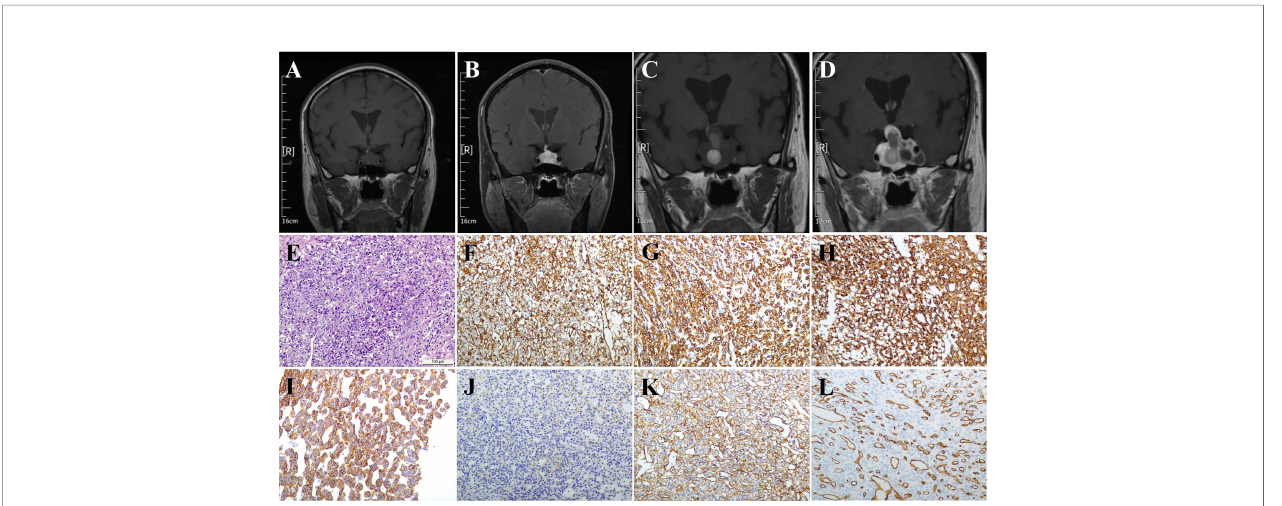
FIGURE 1 | MRI and pathological images. (A, B) Five years before the operation: Coronal MRI and enhanced MRI images indicated the sellar lesions with a size of approximately 21.0 × 14.5 × 12 mm had cystic structures and was inhomogenously enhanced. (C, D) Three months before the operation: Coronal MRI and enhanced MRI images indicated the sellar lesions with a size of about 37 × 35 × 24 mm had variable signal intensity and multiple apoplectic events. (E) Hematoxylin- eosin (H&E) staining indicated the mild cell morphology with rare nuclear division; immunohistochemical staining indicated that the tumor cells were positive for (F) Vimentin, (G) SMA, (H) SYN, (I) h-caldesmon, (J) Desmin, (K) Collagen IV, and (L) CD34. Magni fi cation, ×200; Bar = 100 m